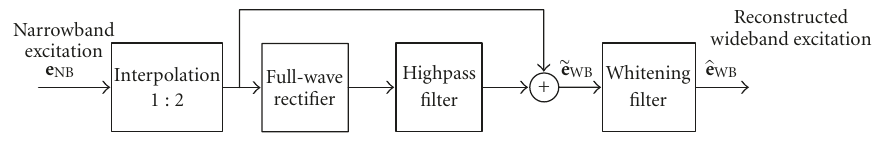
Figure 3: Artificial WB excitation